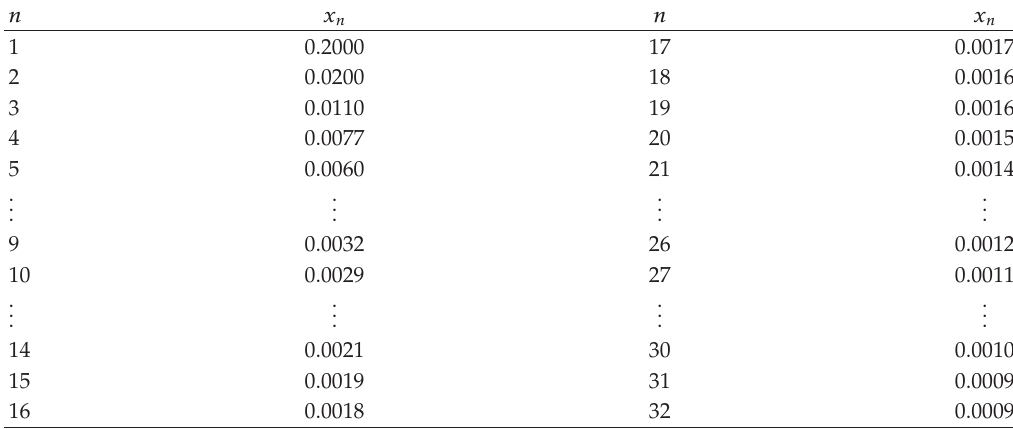
Table 1: This table shows the value of sequence { x n } on each iteration step (cid:3) initial value x 1 (cid:5) 0 . 2 (cid:4) . n x n n x